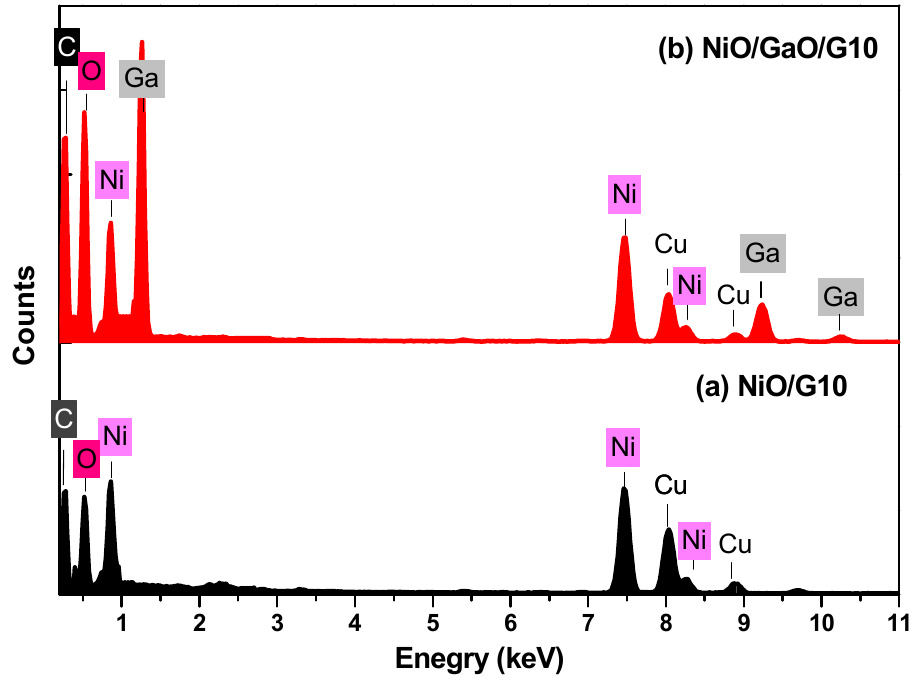
Figure 4. EDX spectra for the distribution of Ni, Ga, O, and C elements for ( a ) NiO/G10, and ( b ) NiO/Ga 2 O 2 /G10 nanocomposites. Table 1. The weight and atomic percentages of the Ni, Ga, O, and C elements calculated from EXD spectra of NiO/G10 and NiO/Ga 2 O 2 /G10. Element